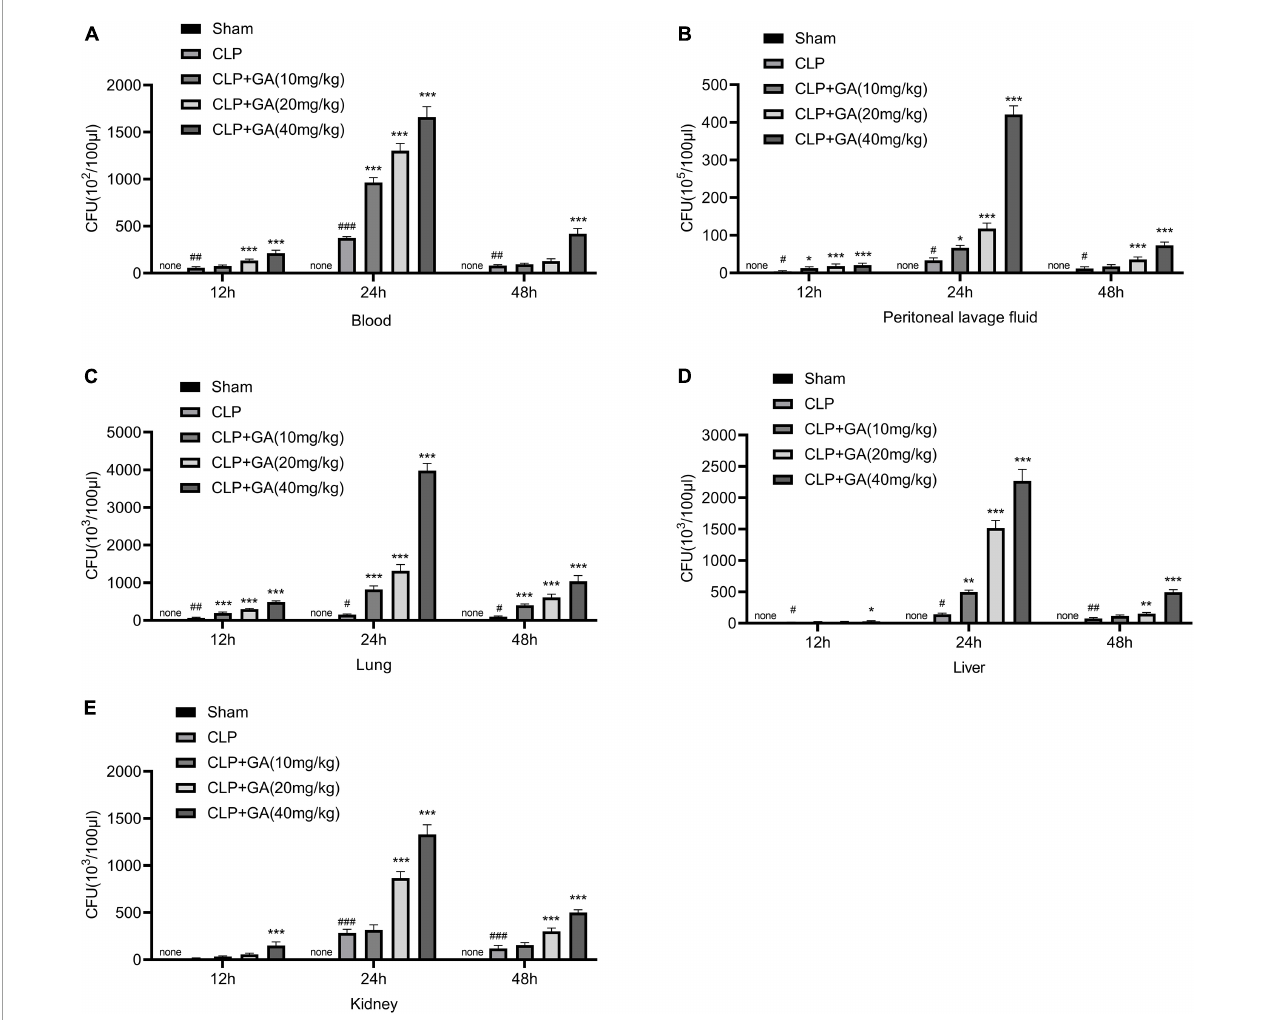
FIGURE3 Ginkgolic acid (GA) increases bacterial burdens in blood, peritoneal lavage fluids (PLFs), and organs of septic mice. Blood, PLFs, lungs, liver, and kidneys were collected aseptically at 12, 24, and 48 h after cecal ligation and puncture (CLP) operation. Bacterial colony-forming unit (CFU) counts were performed in (A) blood, (B) PLFs and tissue homogenates of (C) lungs, (D) liver, and (E) kidneys. CFU indicates colony forming units. Data were calculated with the mean ± SD ( n = 4). # P < 0.05, ## P < 0.01, ### P < 0.001 versus the Sham group; ∗ P < 0.05, ∗∗ P < 0.01, ∗∗∗ P < 0.001 versus the CLP